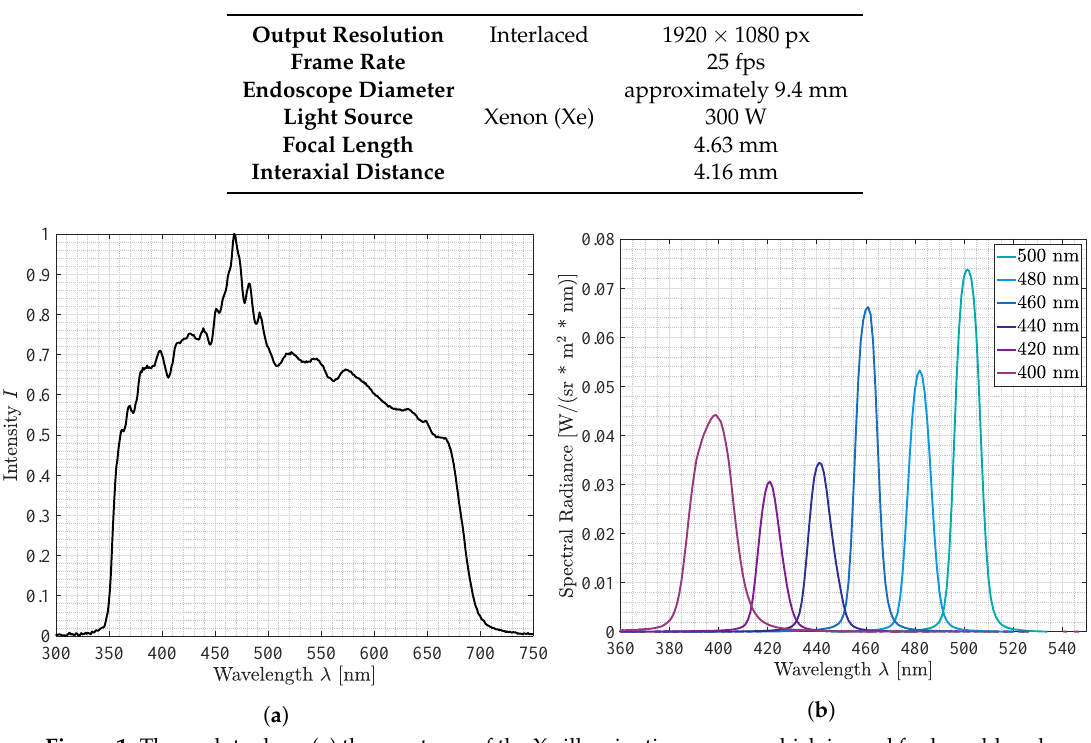
Table 1. Specifications of the 3D-endoscope camera: sensor and calibrated lens values.